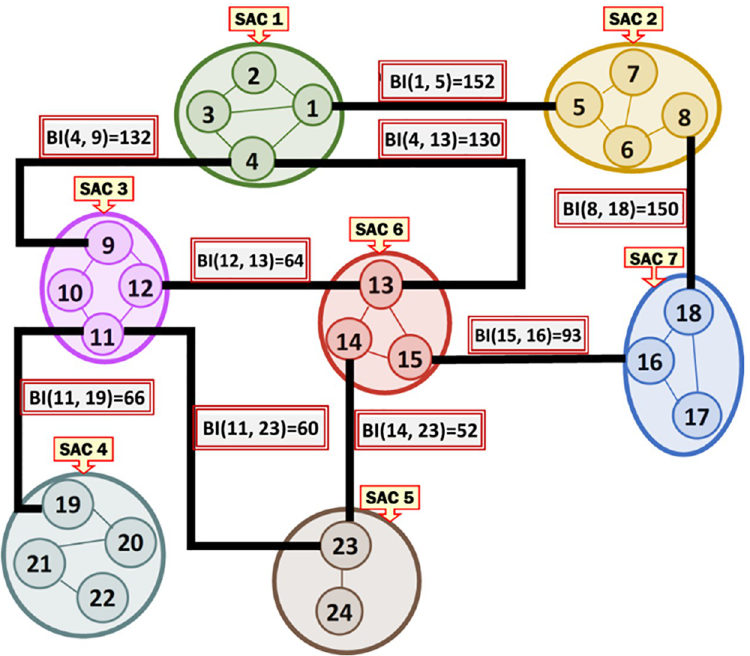
Fig 6. The BI scores of all the Association Edges in our running MRG example after applying Eq 4 (recall Fig 3).